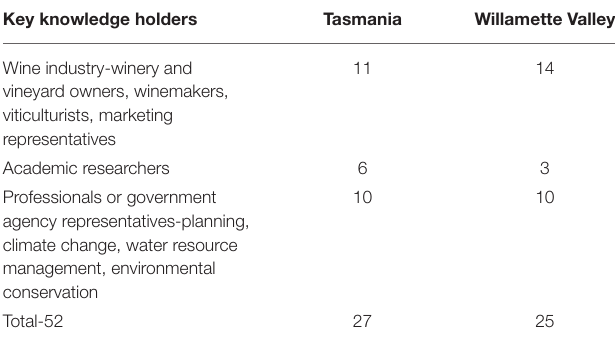
TABLE 2 | Table of key knowledge holder interview participants. Key knowledge